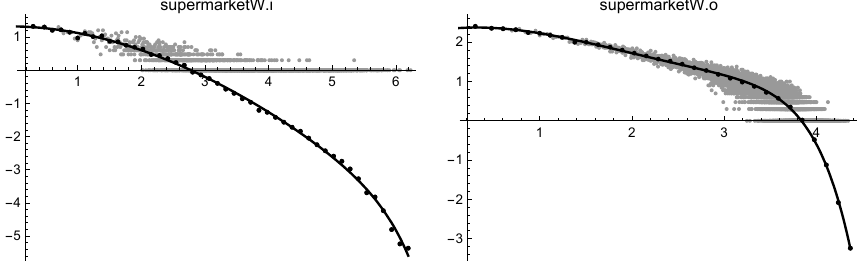
Figure 9. log-log solutions of supermarketW.i ( on the left ) and of supermarketW.o ( on the right